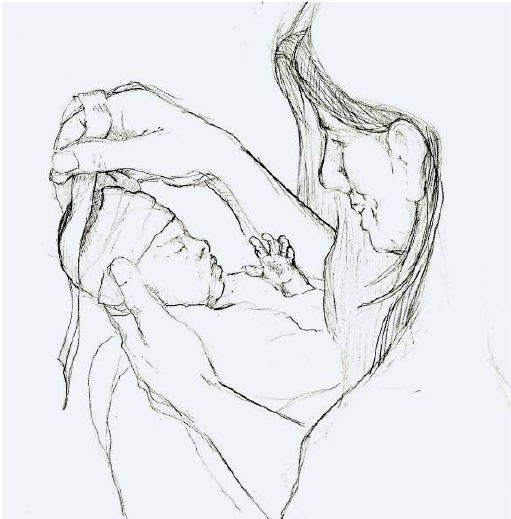
Figure 17. Artistic rendering of a parent carrying out the practice of head-shaping on his/her infant. This practice may have set some members of the Çadır community apart from others (drawing by Laurel D. Hackley).